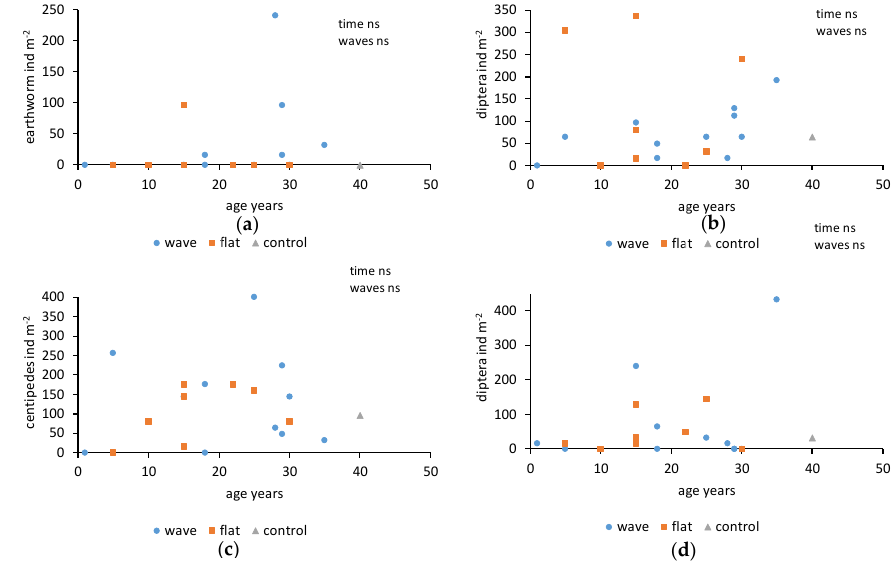
Figure 5. ( a ) Earthworms, ( b ) dipterans, ( c ) centipedes, and ( d ) millipedes in postmining sites of various ages which were either levelled (flat) or not (wave). Control was a forest unaffected by mining; p values shown for effect of plot age (time) and presence of wavy surfaces (waves).